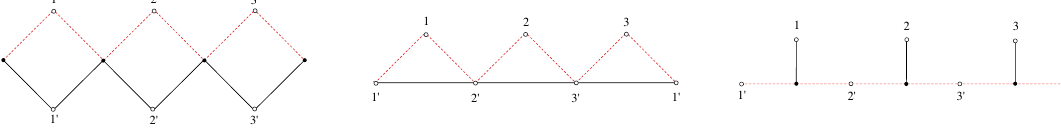
Figure 21 . Left: integral kernel of the transfer matrix operator t ( a ) ( u ) for a spin chain of length L = 3 , for auxiliary space in the Weyl fermion representation (3 / 2 , 0 , 1) and physical spaces in the scalar representation (1 , 0 , 0) . Center: the transfer matrix kernel at u = − 5 / 4 takes the shape of a triangular lattice wrapped onto a cylinder. Right: by means of star-triangle duality the triangular lattice can be re-written as an hexagonal lattice, with fermions propagating in angular direction and scalars along the cylinder.